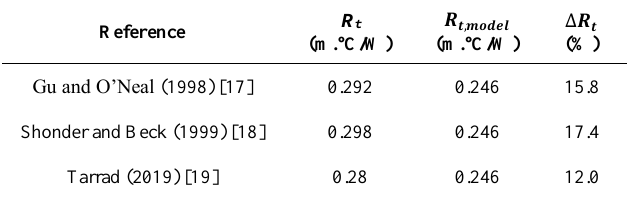
Table 4. Comparison of the single U-tube total thermal resistance with published correlations